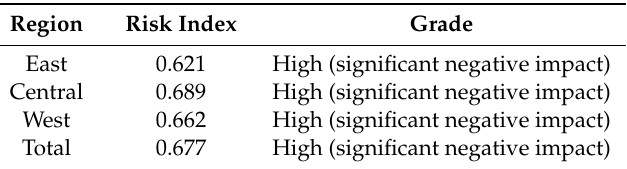
Table 7. Social risk assessment results in China